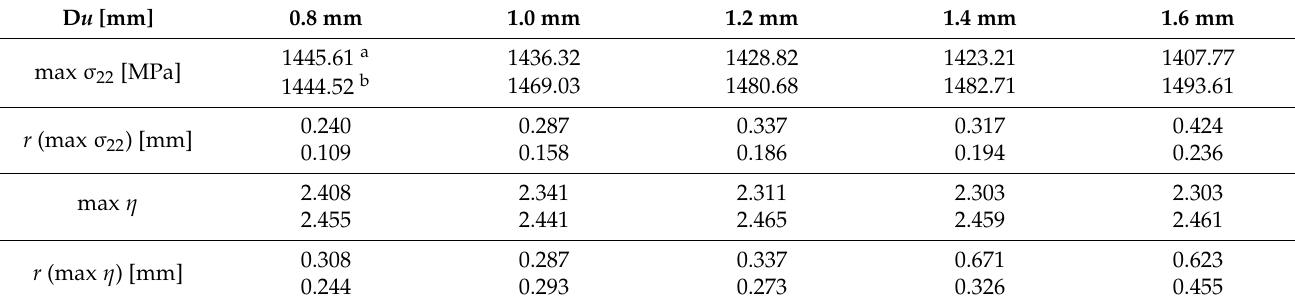
Table 4. Characteristic values of stress distributions at front of the crack tip.